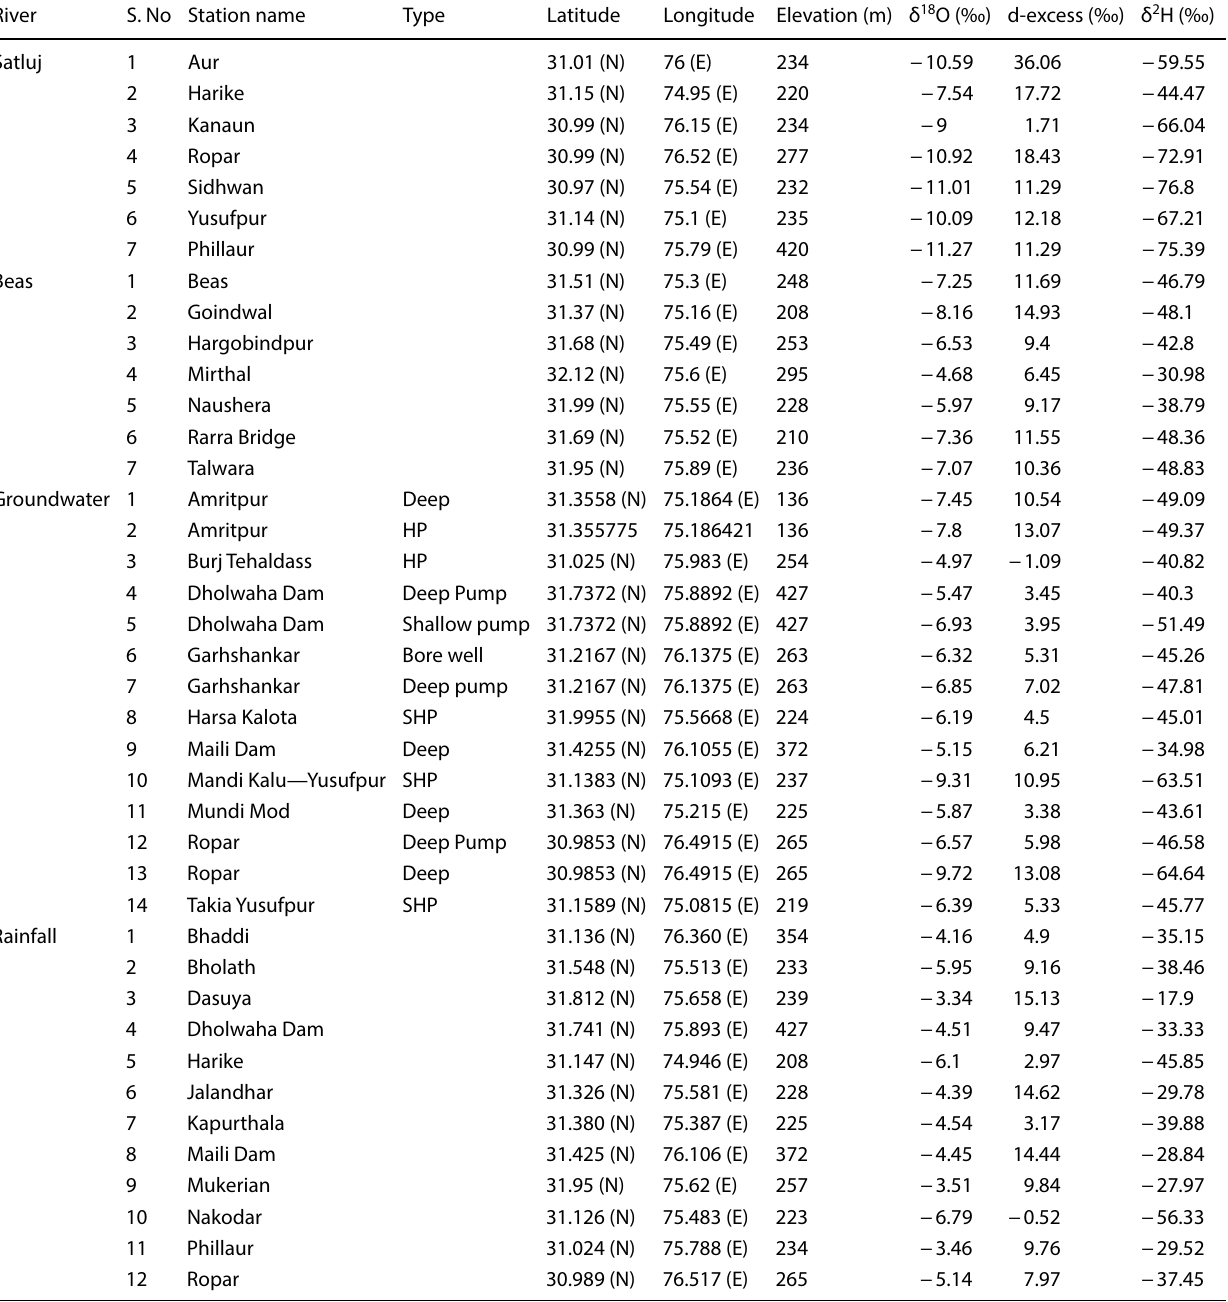
Table 1 Latitude, longitude, elevation of the water sample stations of the river Beas, the river Sutlej, rainfall and groundwater